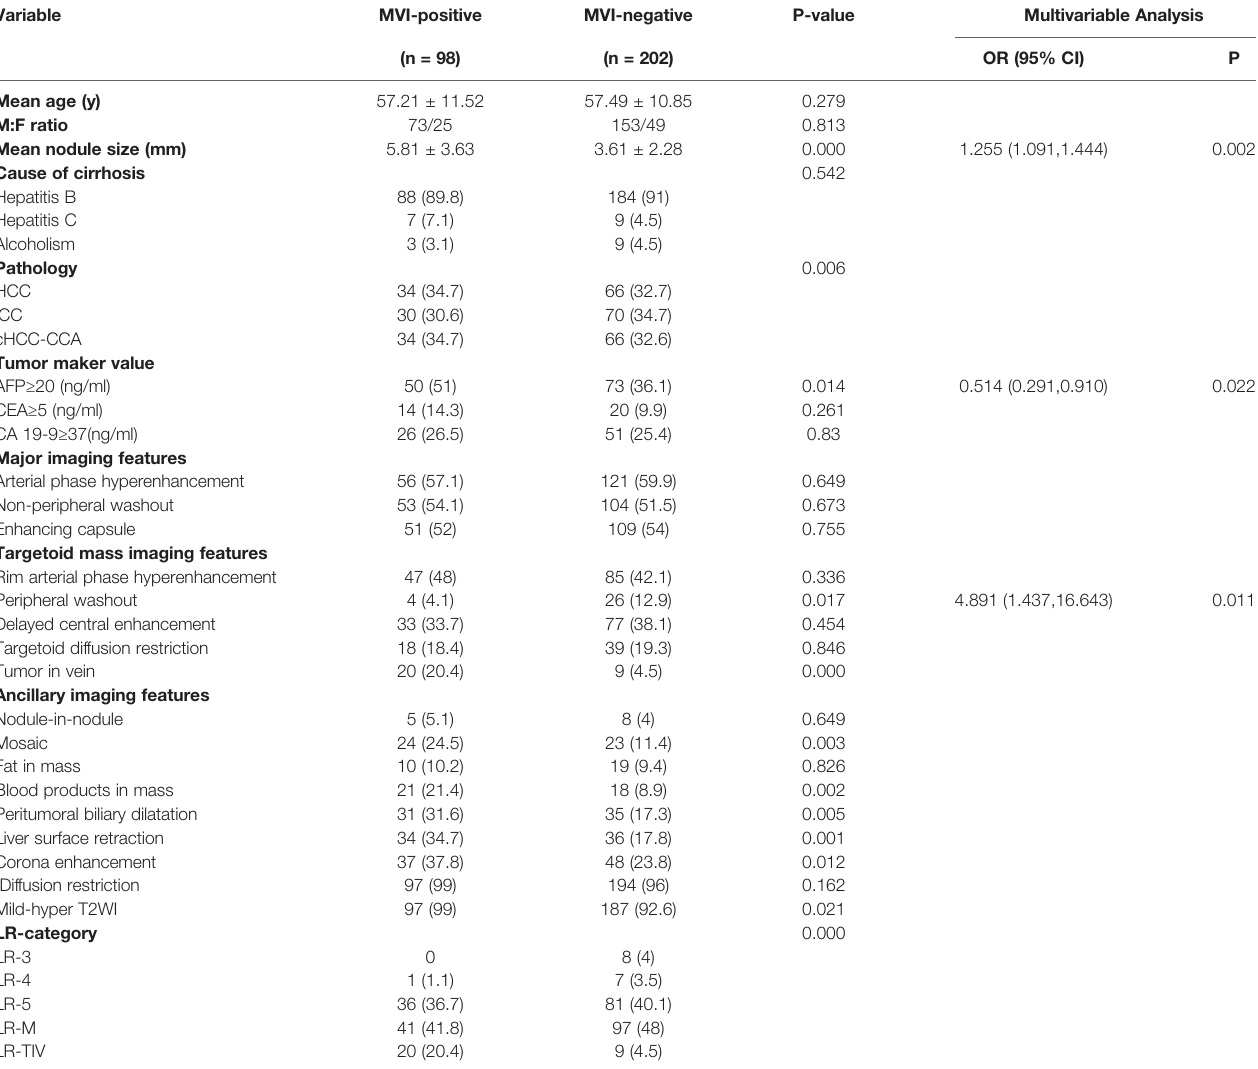
TABLE 5 | Clinical characteristics and multivariate analyses of risk factors for the MVI of primary liver cancer.